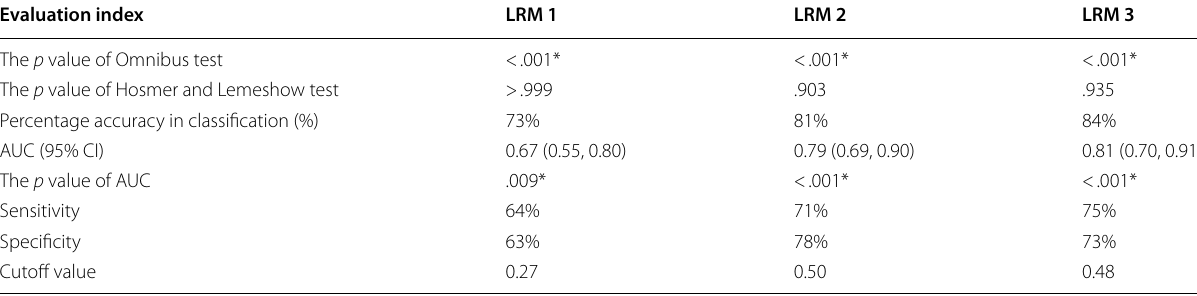
LRM logistic regression model, AUC area under the curve, CI confidence interval * p values less than